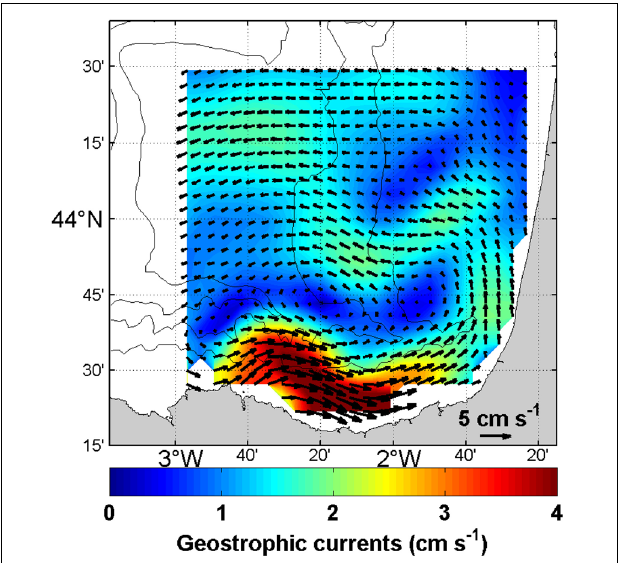
FIGURE 5 | Mean geostrophic currents (cm s − 1 ) in the SE-BoB measured from the HF radar and computed following the process explained in section “HF Radar